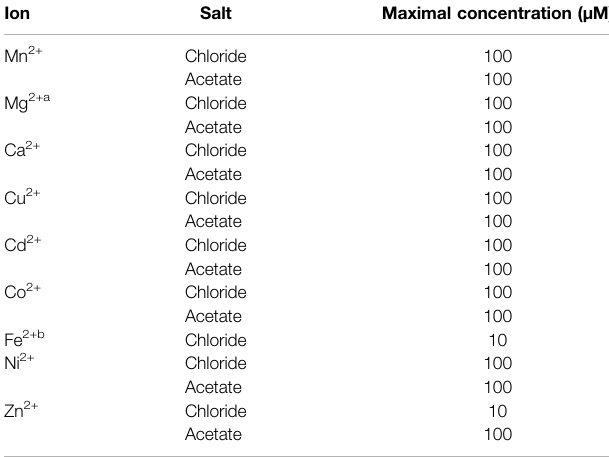
TABLE 3 | Maximal concentration for added